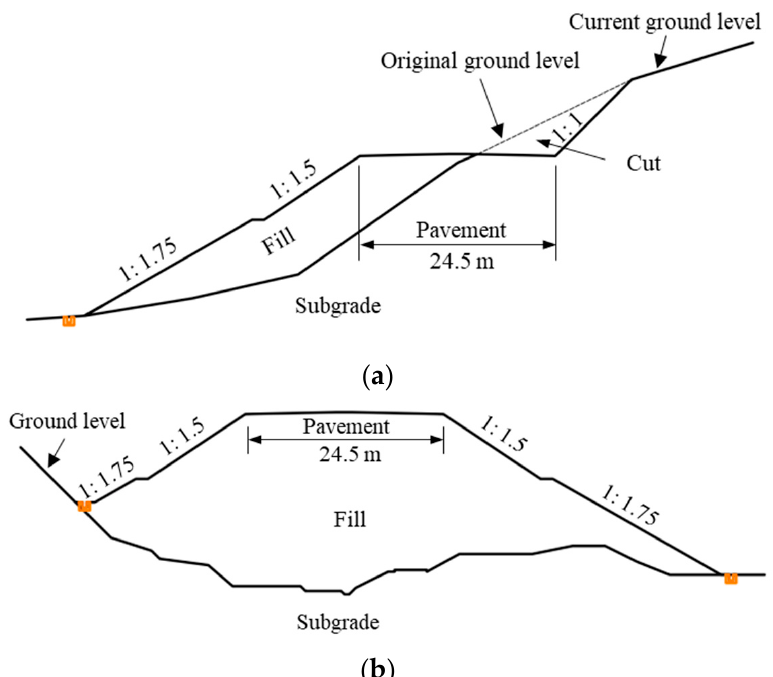
Figure 2. Cross-sections of the typical highway subgrades. ( a ) A typical cut-and-fill section. ( b ) A typical fill section. Table 1. Information on the damaged highway